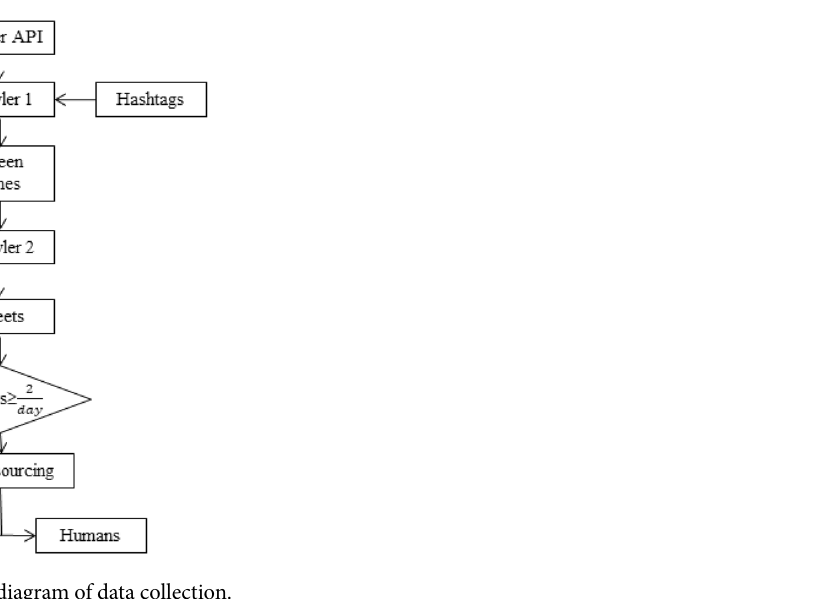
Figure 2. Flow diagram of data